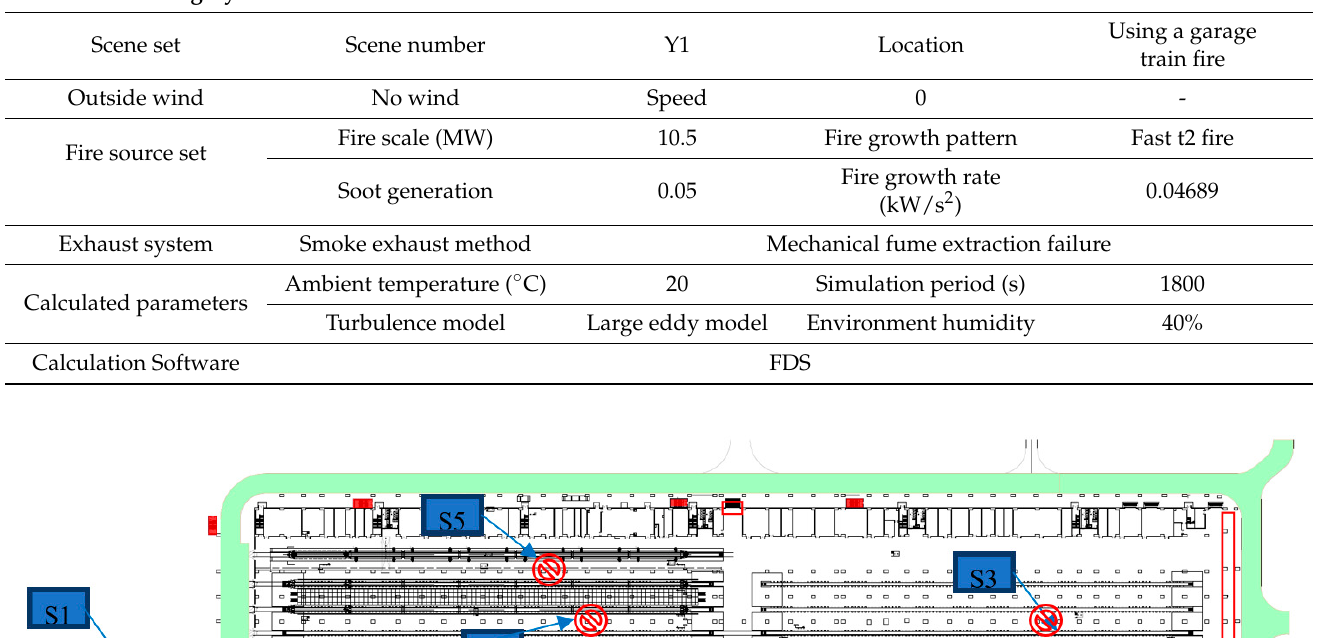
Table 11. Smoke scene Y1 parameters. Table 10. Evacuation scenario table.